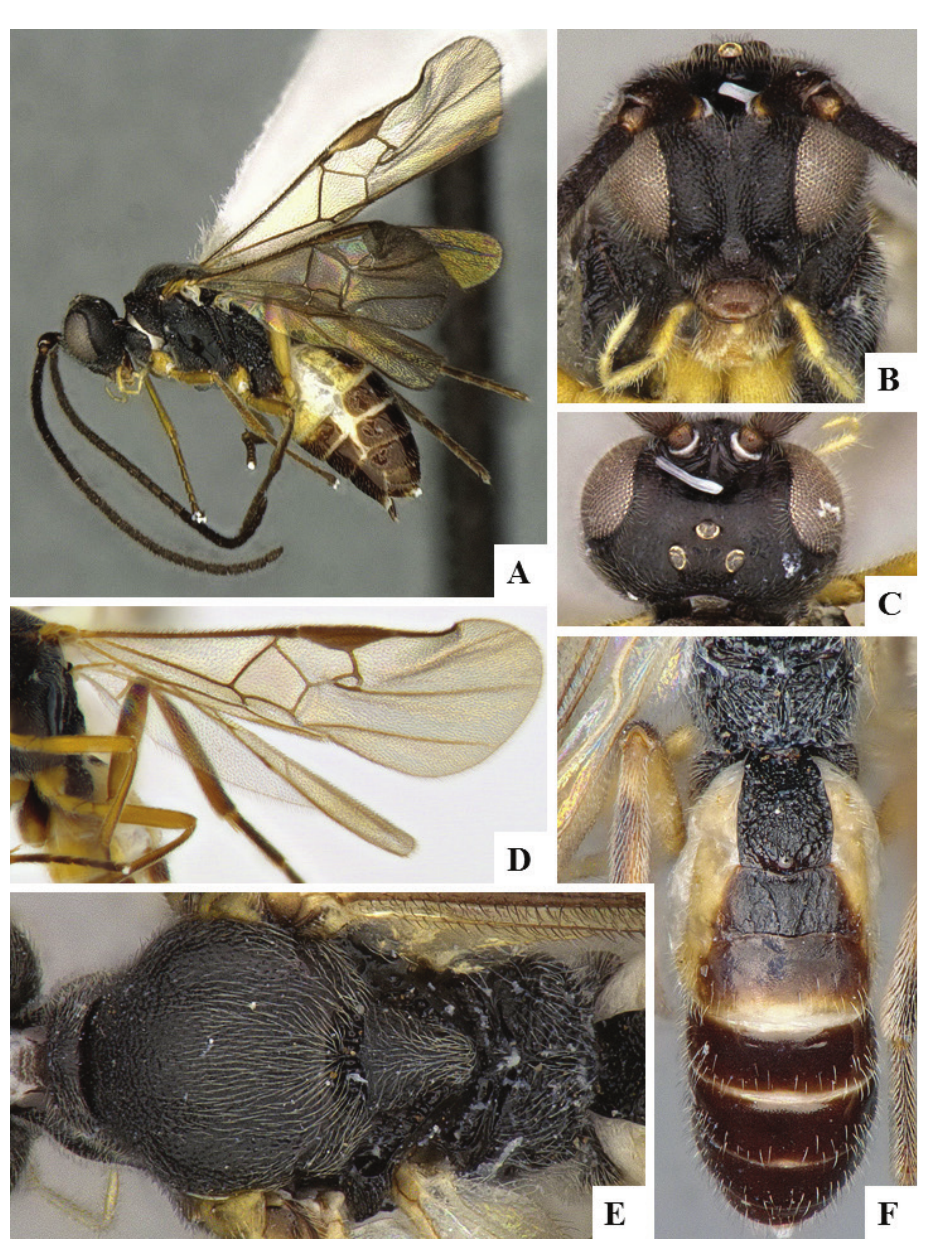
Figure 18. Jenopappius aethiopica female non-type specimen CNC878534. A Habitus B Head frontal C Head dorsal D Fore wing E Mesosoma dorsal F Metasoma dorsal. scription of J. aethiopica (where the color of those body parts is described as mostly reddish-yellow or reddish-brown), but we consider those as minor differences and thus keep all examined specimens as part of J. aethiopica